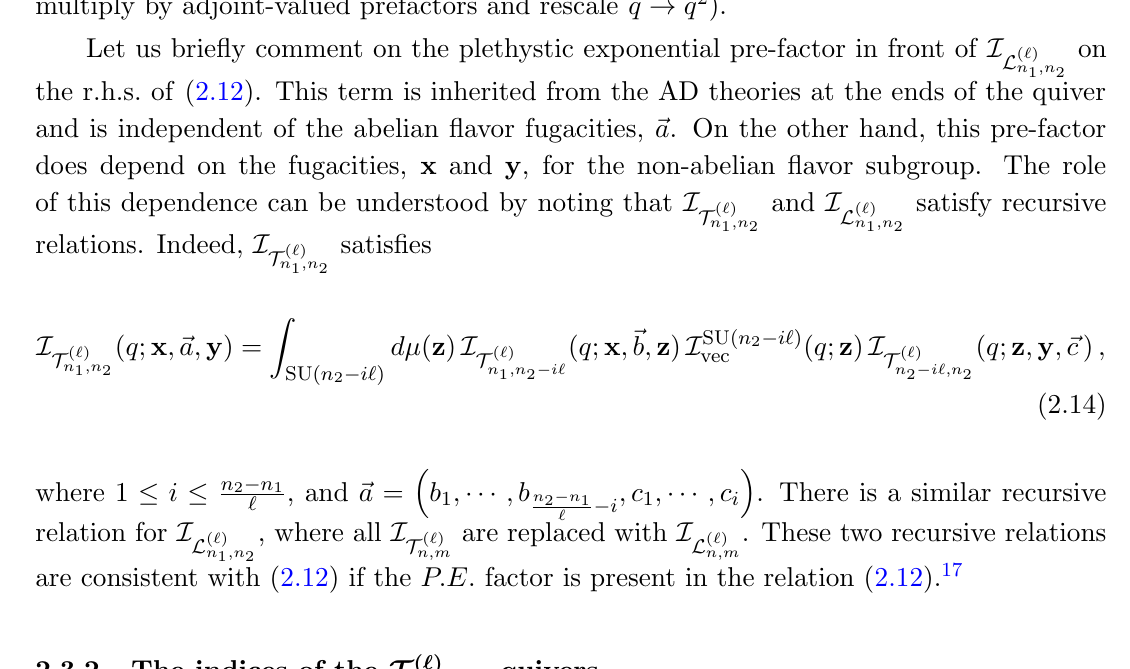
Figure 4 . The quiver diagram of the Lagrangian theory we call L ( ‘ ) n two nodes stands for a bifundamental hypermultiplet, and each box labeled by \ n " stands for n fundamental hypermultiplets. The (cid:13)avor symmetry of L ( ‘ ) n of T ( ‘ ) n 1 ;n 2